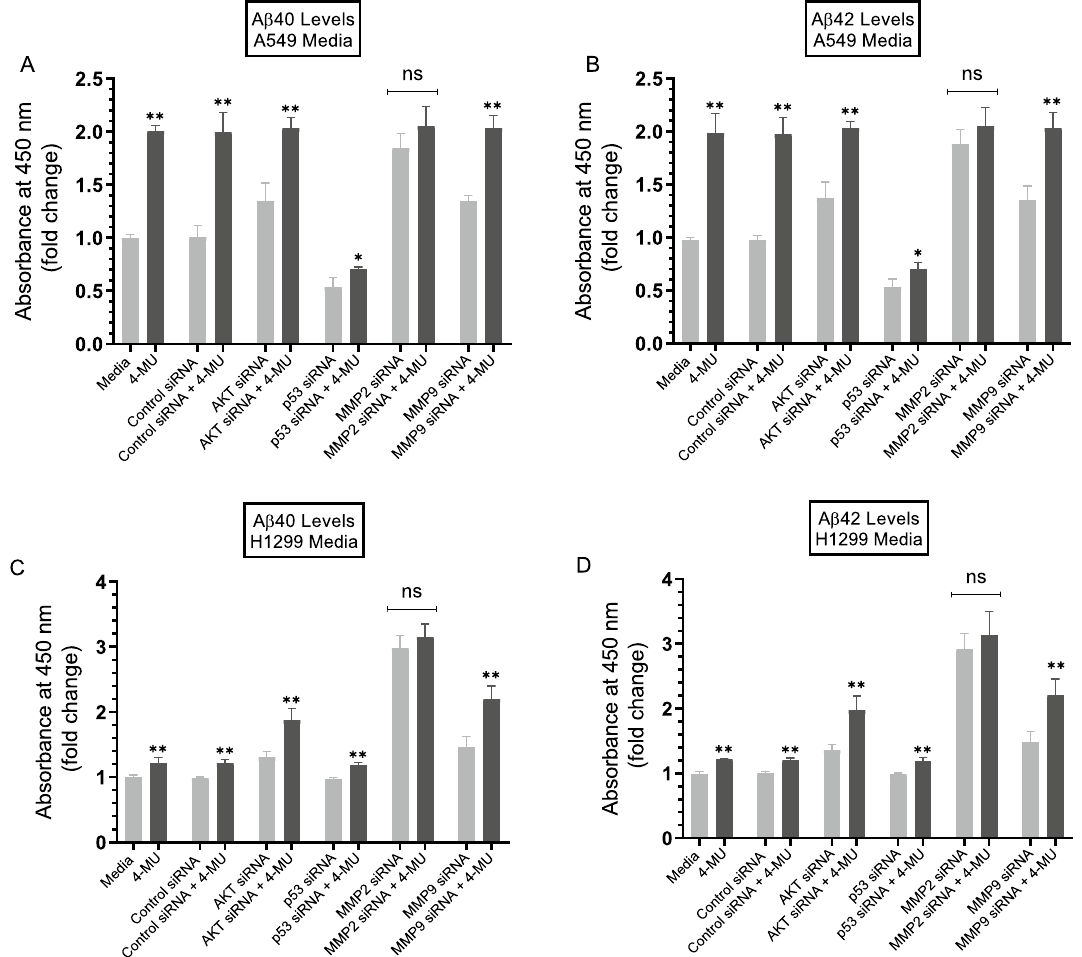
Figure 8. Treatment of cells with MMP2 siRNA resulted in comparable increases in the levels of Aβ in the media of both A549 and H1299 cells as that upon cell co-treatment with 4-MU. Cells (0.2 × 10 5 ) were grown in 10% FBS-supplemented media for 24 h. The following day, the cell monolayers were incubated in serum- free media for 24 h, then treated for 72 h with the indicated siRNAs without or with added 600 µM 4-MU as described in the “Methods” section. The same amount of protein (3 µL of 600 µg/mL total protein) of the media was used to quantitate Aβ (“Methods” section). Data from five independent assays, each carried out in triplicate, were quantitated, averaged, normalized, and expressed as fold change relative to cells not treated with 4-MU using the GraphPad 8.4.3 software. The graphs summarize the results expressed as means ± SD (n = 5). Asterisks (*) indicate a statistically significant difference from the corresponding samples without 4-MU treatment, * p < 0.05, ** p < 0.01 of each cell line. Absence of asterisks indicates no significance (ns), Mann–Whitney question, media was first collected from different cell treatments then immunodepleted (ID) of Aβ (“Methods” section). Next, viability and apoptosis of A549 and H1299 cells were assessed as described in the “Methods” sec- tion and in Fig. 9 legend. Immunodepletion of Aβ from media of either A549 or H1299 cells transfected with control siRNA resulted in increased viability and decreased apoptosis (Fig. 9) suggesting that Aβ has cytotoxic functions in the media of these cell lines. Incubation of A549 cells with media from control siRNA transfections treated with 4-MU decreased cell viability by ~ 2.0-fold (Fig. 9A), however, when treated with media ID of Aβ under the same condi- tions, there was a ~ 1.55-fold relative increase in cell viability. Conversely, relative to cells treated with media from control siRNA transfections, apoptosis increased ~ 1.55-fold upon treatment of A549 cells with media co-treated with control siRNA and 4-MU, a value that decreased by ~ 1.48-fold when Aβ was immunodepleted (Fig. 9C). Treatment of A549 cells with MMP2 siRNA media decreased cell viability and increased apoptosis by ~ 1.35-fold (Fig. 9A,C). Immunodepletion of Aβ from media of A549 cells treated with MMP2 siRNA resulted in ~ 1.42-fold increase in viability (Fig. 9A) and ~ 1.45-fold decrease in apoptosis (Fig. 9C) compared to undepleted media. Treatment of A549 cells with media from MMP9 siRNA transfection resulted in ~ 1.30-fold decrease in A549 cell viability and ~ 1.20-fold increase in apoptosis. Immunodepletion of Aβ from MMP9 siRNA transfected cell media resulted in ~ 1.18-fold increase in A549 cell viability and ~ 1.16-fold decrease in apoptosis (Fig. 9A,C), effects less pronounced than those observed for MMP2 transfections. Relative to media of cells transfected with